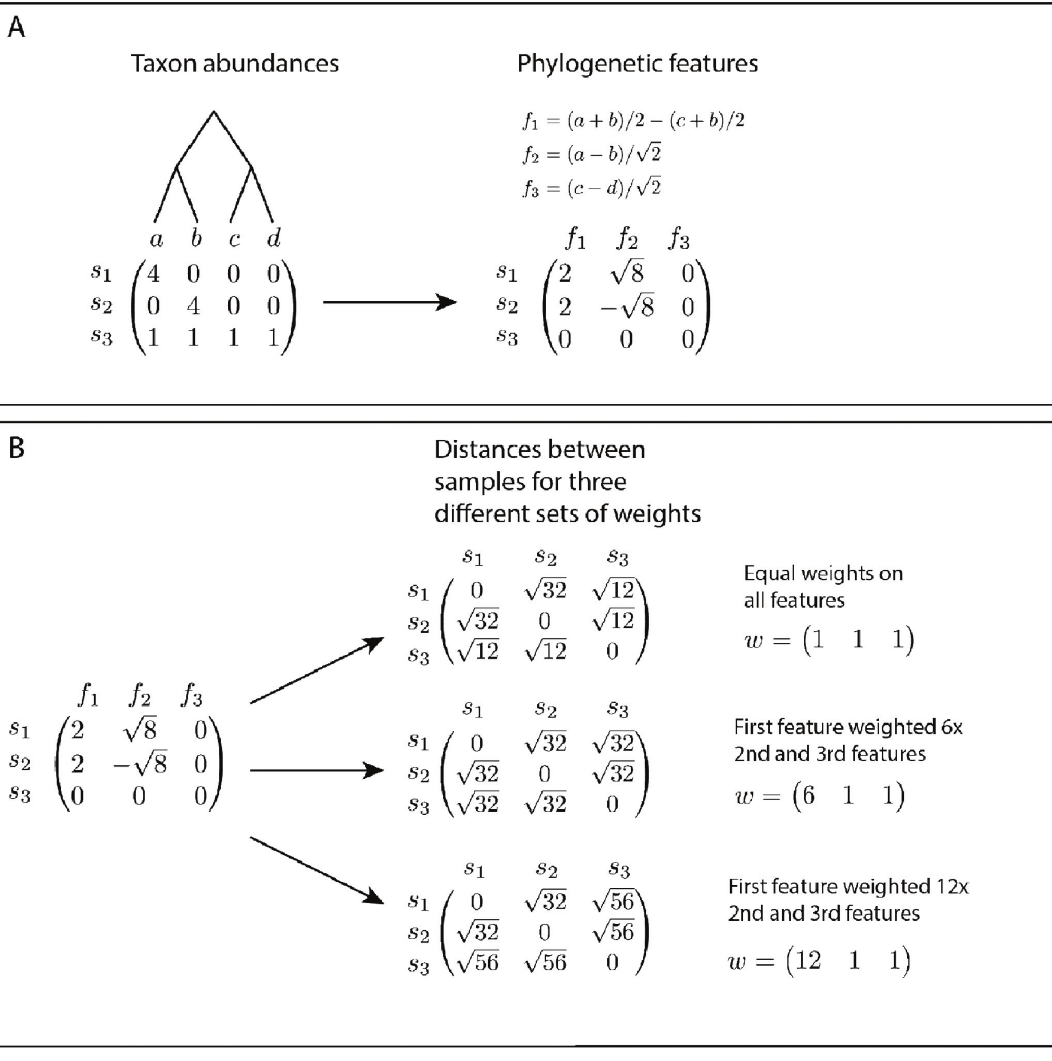
Fig 2. (A) An example of computing phylogenetically-informed features f 1 , f 2 , and f 3 on a taxon abundance matrix. (B) Computing a weighted Euclidean distance between samples s 1 , s 2 , and s 3 using the features defined in (A) and equal weights for the three features (top row), and increased weight on the first feature relative to the second and third features (middle and bottom rows). As we increase the weight on f 1 , the distance between s 3 and the other samples increases compared to the distance between s 1 and s 2